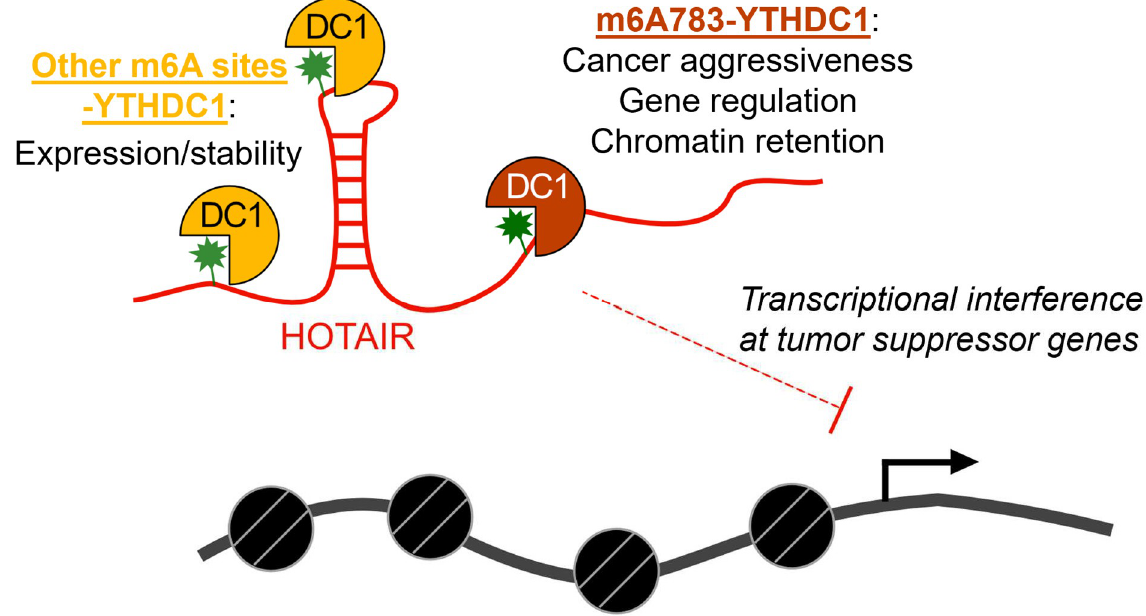
Fig 7. Model of m6A and YTHDC1 effects on HOTAIR. The main function of YTHDC1 on HOTAIR occurs via interaction with m6A783 and mediates chromatin association of HOTAIR to induce transcriptional interference of its target genes, promoting breast cancer growth and invasion. YTHDC1 also interacts with other m6A sites within HOTAIR that mediates its high expression levels and/or stability.